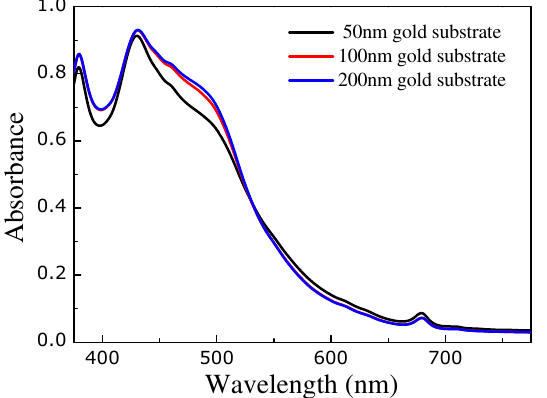
Figure 8. Absorbance of light incident normally on the square array of silver nanocubes Figure 3 with edge L = 70 nm, separated by a 8 nm polyelectrolyte ( ǫ = 2 . 37 ) spacer from a gold substrate (see Figure 1), for different substrate thicknesses, D = 50 , 100 , 200